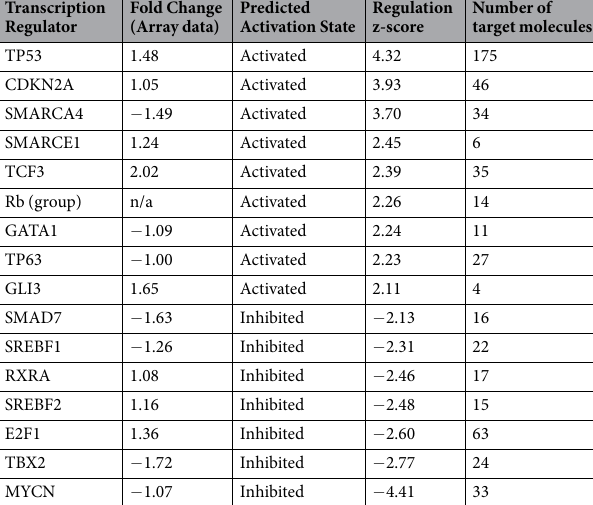
Fold Change (Array data)